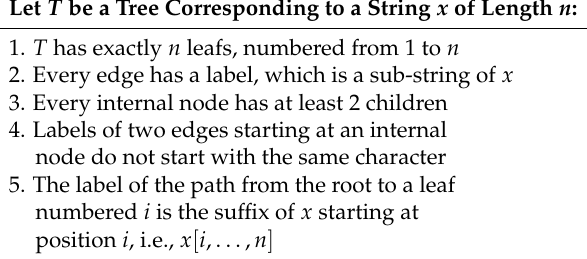
Table 1. Suffix tree construction. An